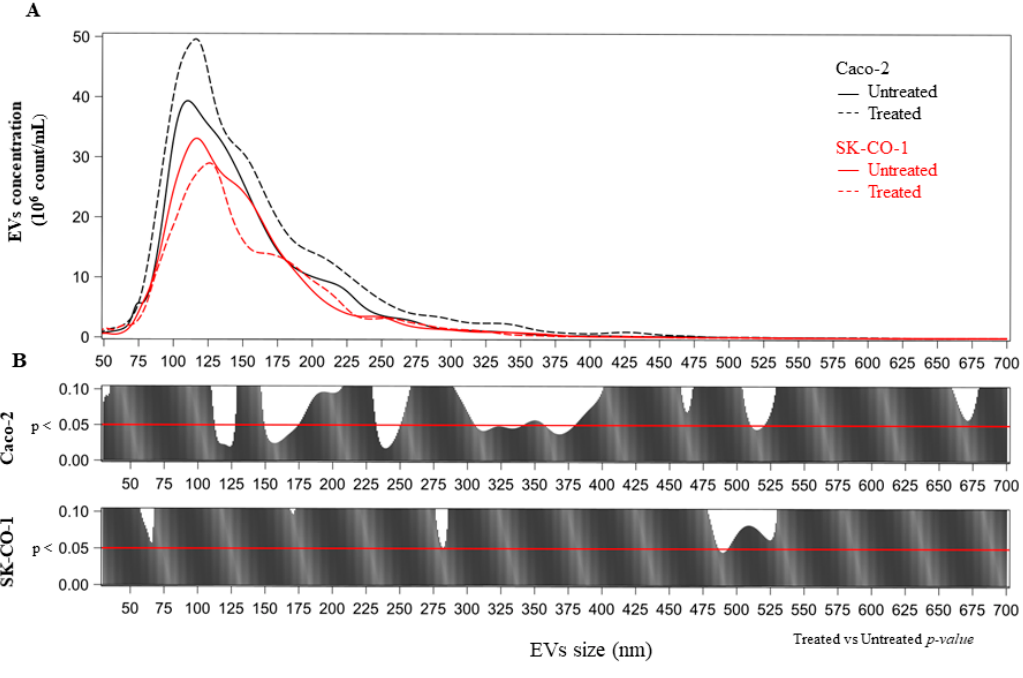
Figure 4. ( A ) Number of EVs ( × 10 6 ) for each size (nm) from Caco-2 and SK-CO-1 cells. ( B ) For each size, the p -value was reported from poisson regression models with repeated measures.